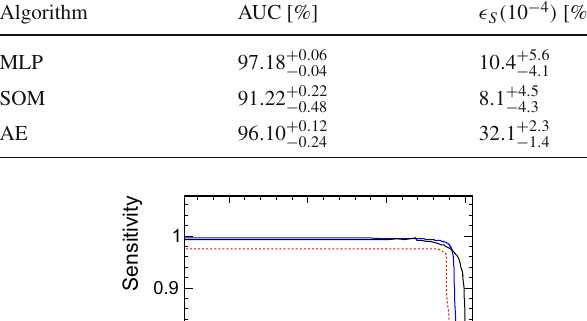
Fig. 17 ROC curve for the classification of antideuterons (signal) and beam background for three different algorithms. MLP multilayer per- ceptreon, SOM self-organising map, AE autoencoder Table 7 Performance metrics of the investigated machine learning techniques for simulated antideuterons Algorithm